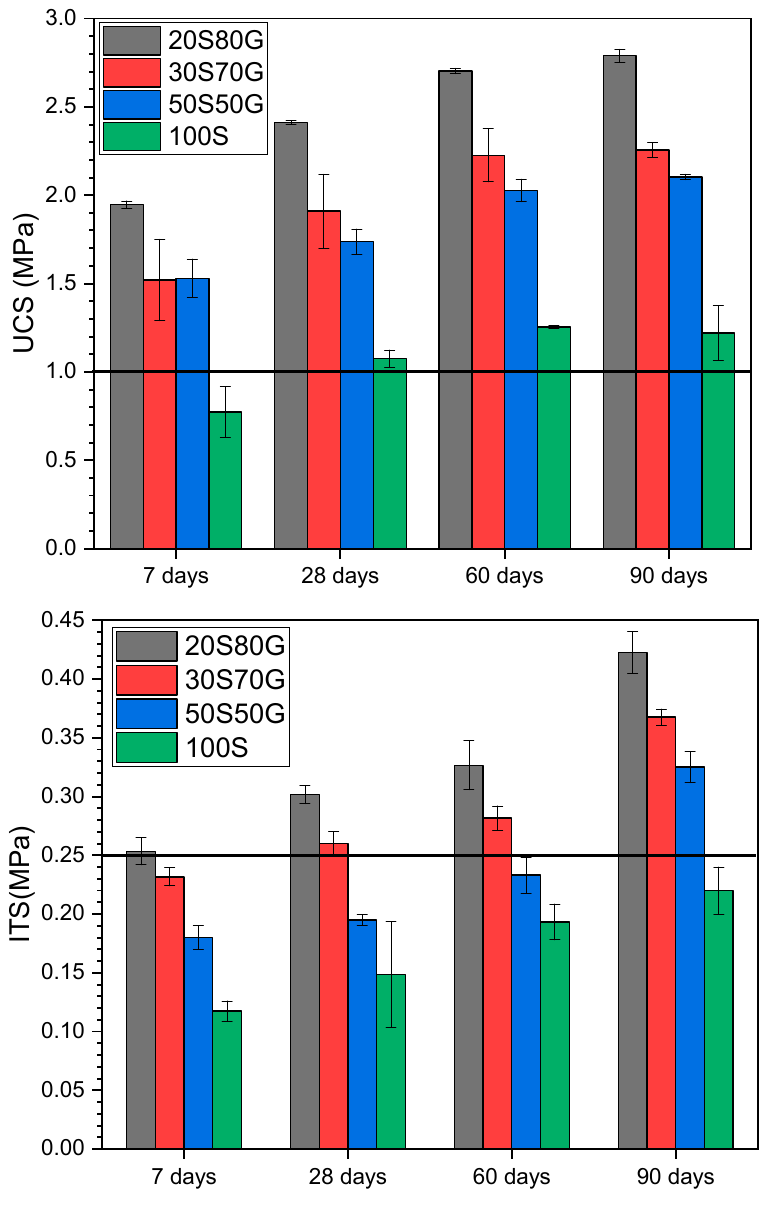
Figure 6. Mix mechanical strength development.